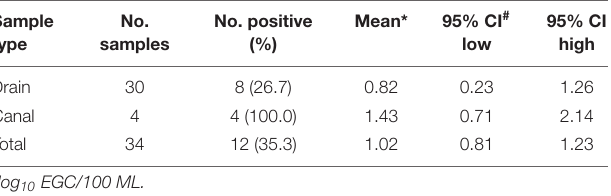
TABLE 3 | ST Detection using the primers/probe described by Karkey et al. (2016) in 20 L of environmental water samples concentrated by Ultrafiltration in Dhaka, Bangladesh, April to October 2019.